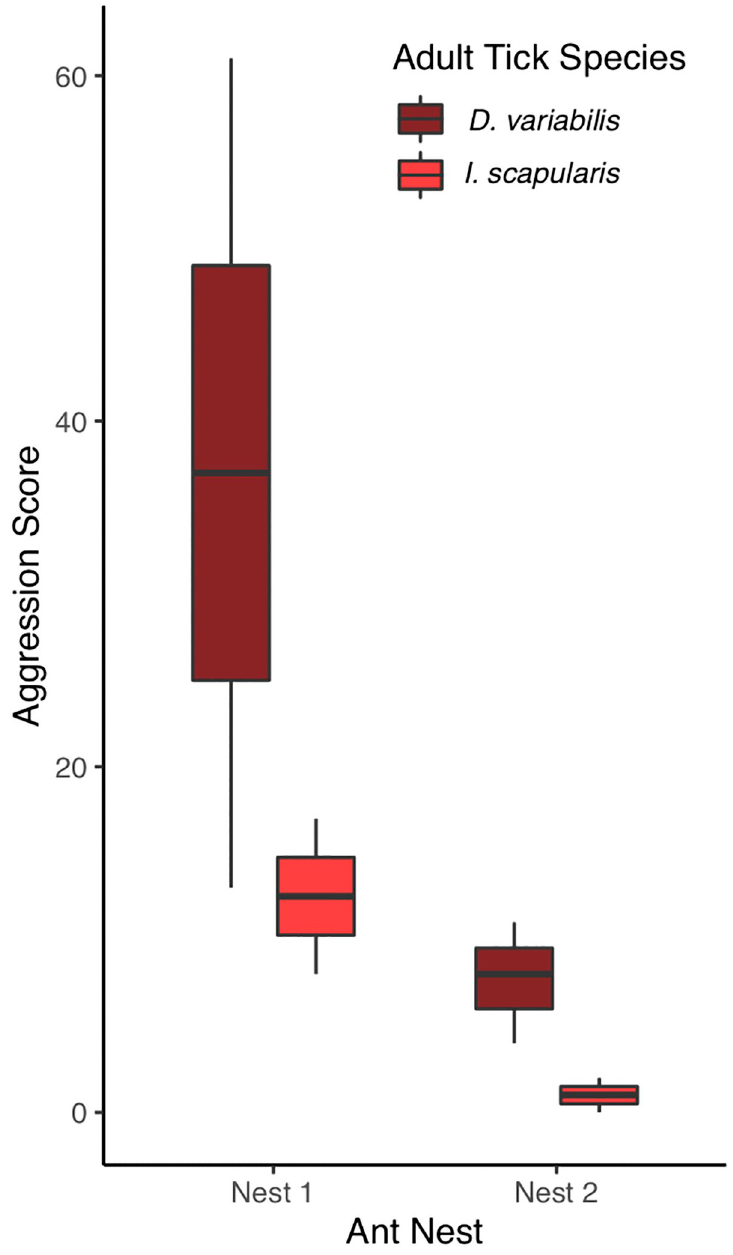
Fig 4. Myrmica rubra aggression scores against unfed adult ticks by tick species and by ant nest. No aggression was documented against nymphs or